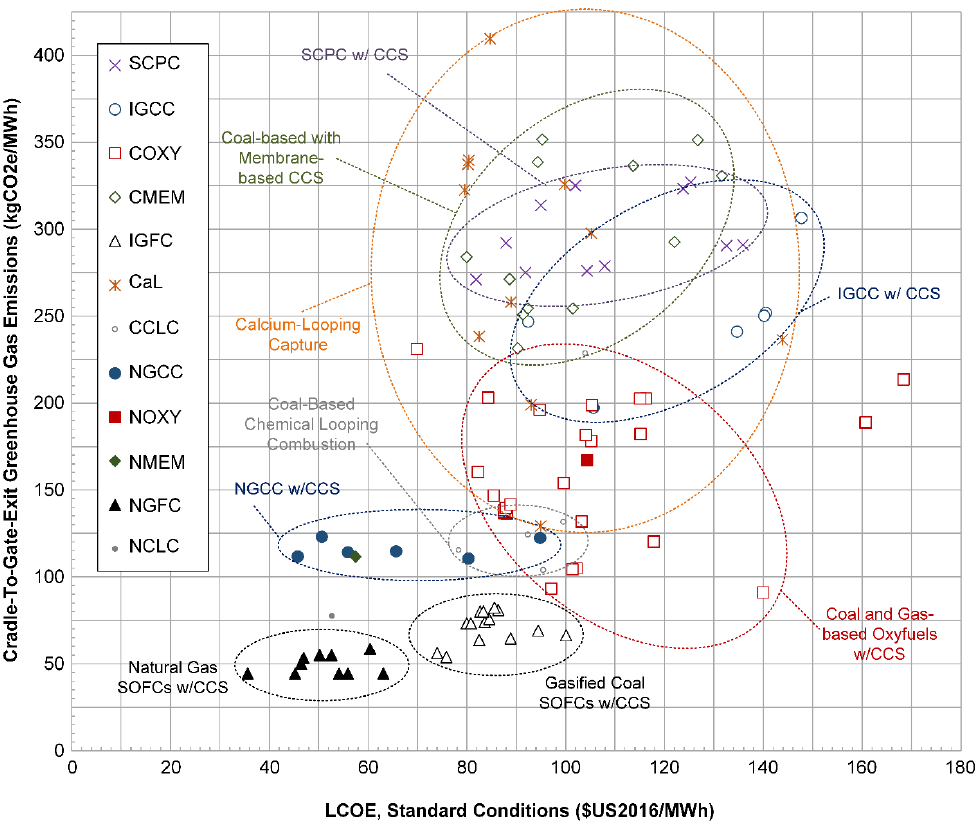
Figure 12. Scatter plot of the calculated LCOE at standard conditions of each plant vs. the calculated life cycle greenhouse gas emissions, using as ‐ reported fuel price assumptions. NOXY = natural gas ‐ based oxyfuels, NMEM = natural gas based membranes, NGFC = natural gas (solid oxide) fuel cells, and NCLC = natural gas ‐ based chemical looping combustion. The oxyfuel system and calcium ‐ looping capture studies show the widest variation in GHG emissions and LCOE, but in general, oxyfuels have lower GHG emissions than the IGCC, SCPC, or coal ‐ based membrane systems for approximately the same cost. The fuel type does not matter much, although the data on gas ‐ based oxyfuels are few. Our ellipse drawn for the general oxyfuels region does not include the outliers COXY ‐ 9 (with very low LCOE) and COXY ‐ 12 and COXY ‐ 13 (with very